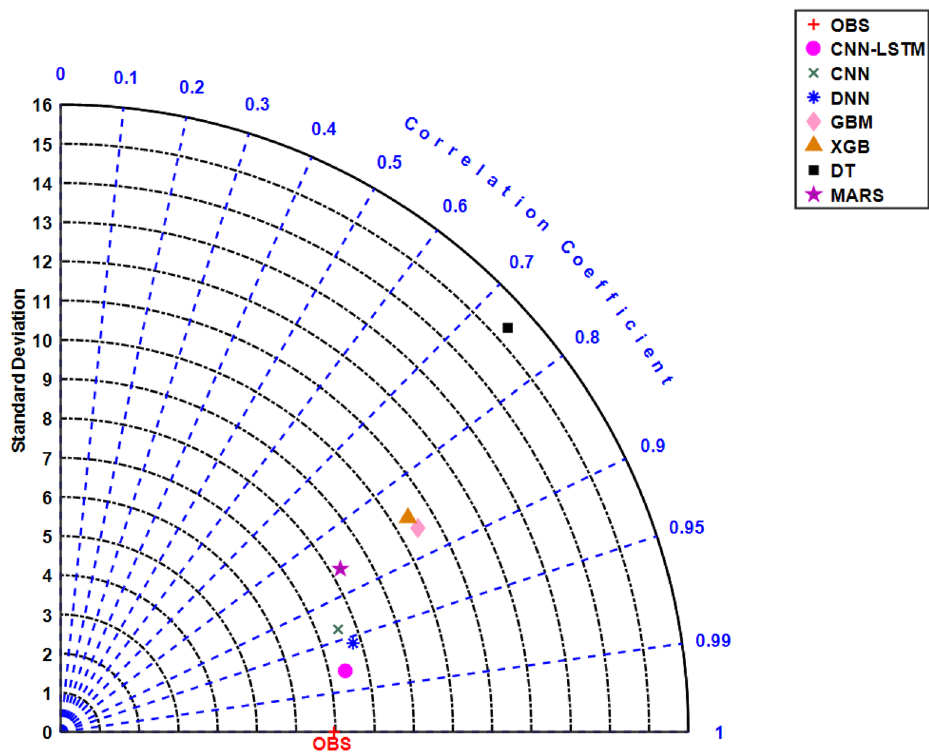
Figure 15. Taylor diagram showing the correlation coefficient between observed and predicted streamflow ( Q , m 3 s −1 ) and standard deviation of CNN-LSTM, Convolutional Neural Network (CNN), Deep Neural Network (DNN), Multi-Layer Perceptron (MLP), Gradient boosting regression (GBM), Extreme Gradient Boosting Regression (XGB) model, Decision Tree (DT) and Multivariate Adaptive Regression Splines (MARS) during testing period (4-Week) for Brisbane